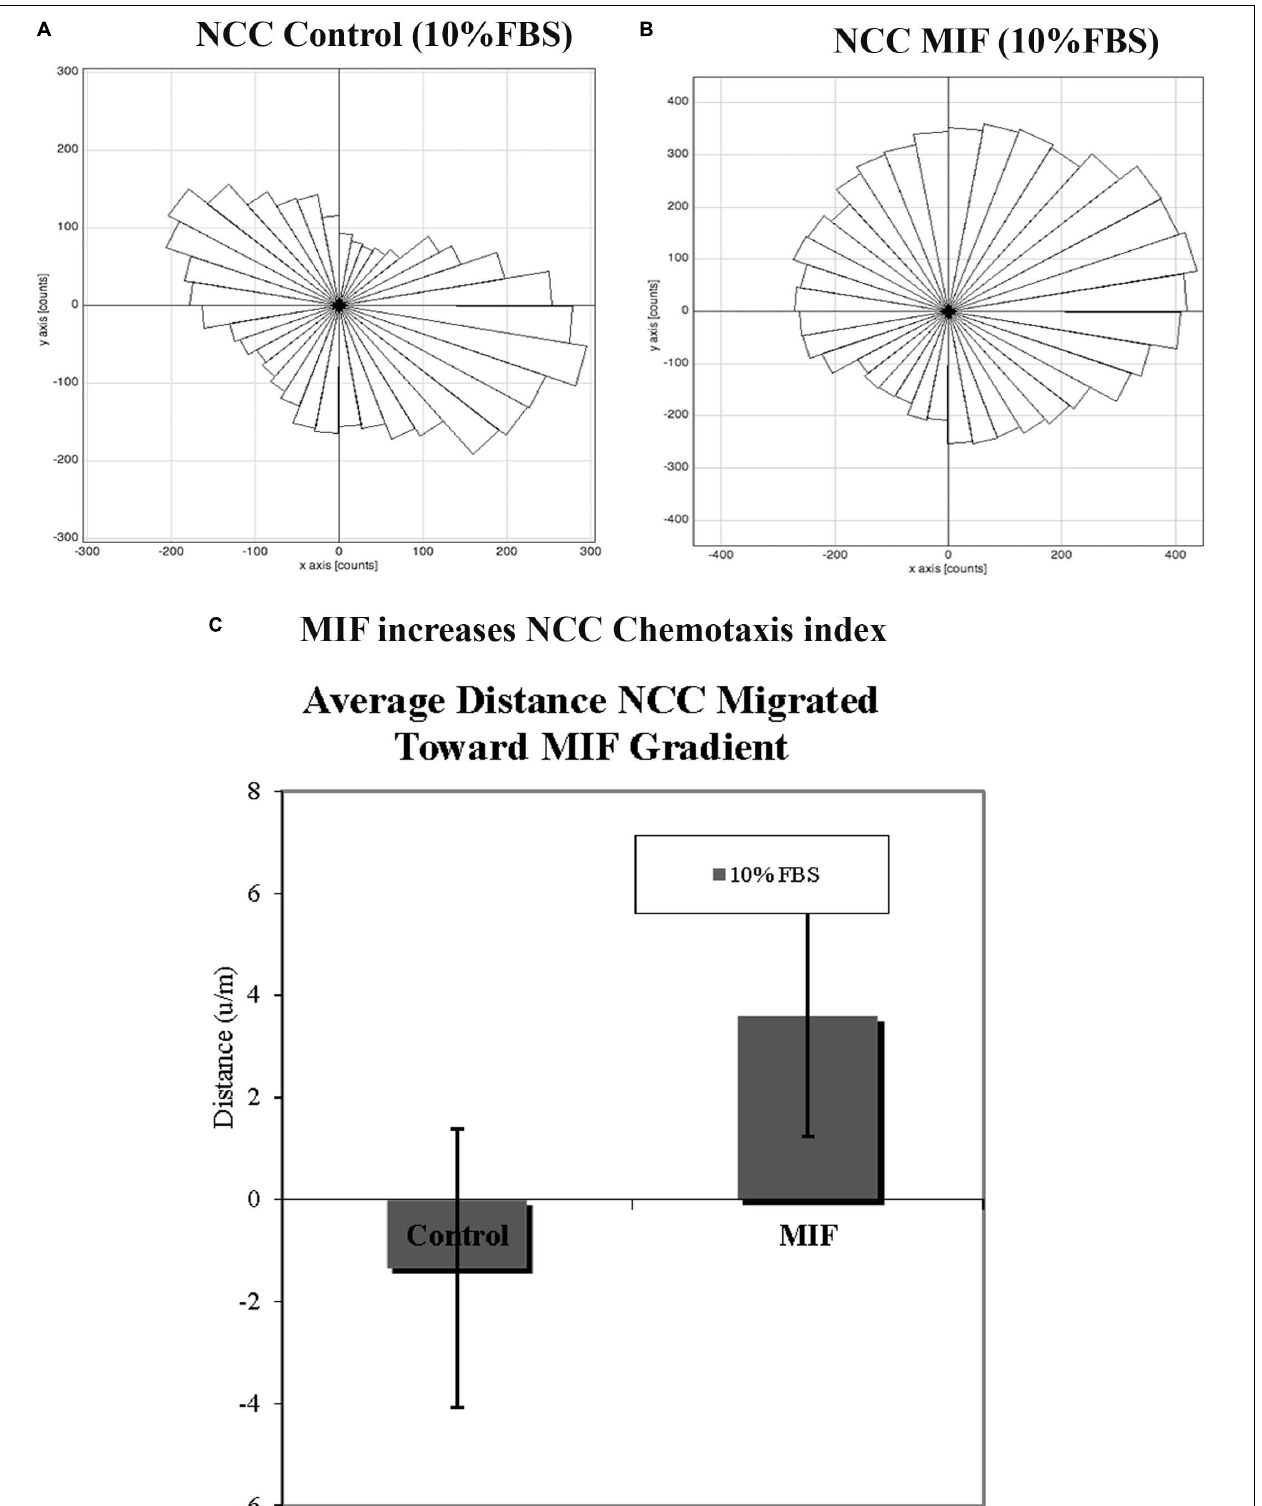
FIGURE 11 | MIF attracts tNCC in vitro . Isolated tNCC were seeded Ibidi chambers in the presence (B) or absence of MIF (A) . Graph shows a rosette presentation of all the tracked paths. MIF was in the top chamber were we observed most of the tNCC in contrast to control that there are equal numbers of tracks in top and bottom portion of the graph. (C) Graph of chemotaxis index from (A,B) experiments. MIF index is significantly positive (attractant) compared with control media.